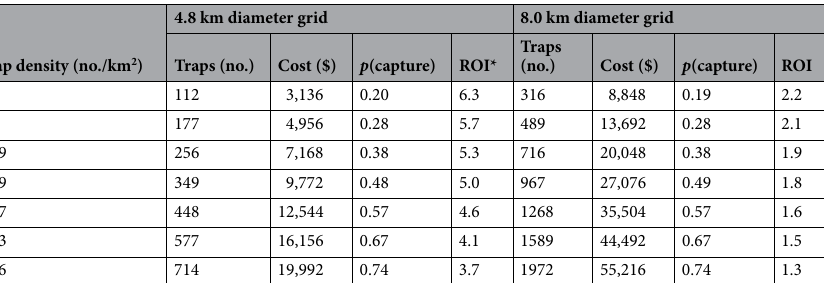
Trap density (no./km 2 )